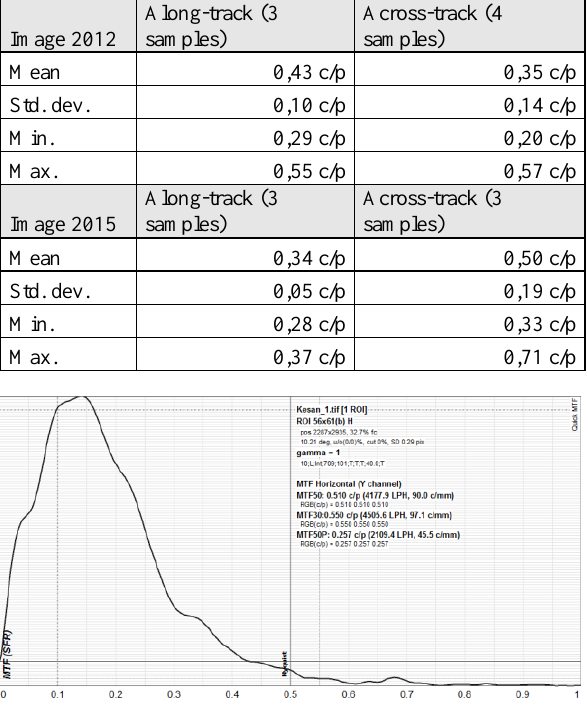
Figure 6. MTF analysis output in Quick MTF for the edge sample in Figure 5 (left image).